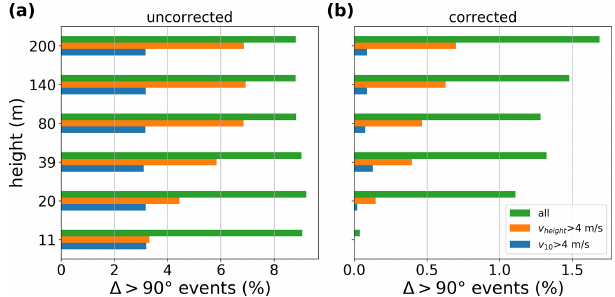
Figure 14. (a) Histogram of the (cid:49) > 90 ◦ events for the differ- ent measuring heights, based on either all events (green), wind speeds larger than 4ms − 1 at the measuring height (orange) and 10m (blue). Panel (b) is the same as (a) but after application of the correction scheme (see text), based on information from the 10m mast wind